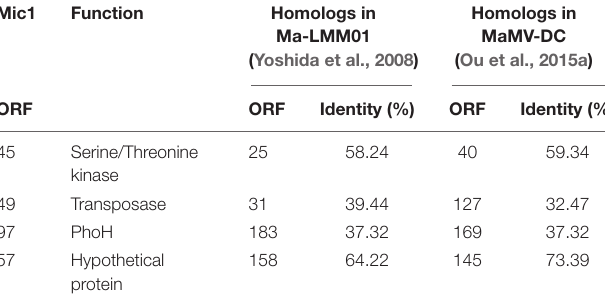
TABLE 1 | Homologs in cyanophages that infect M.